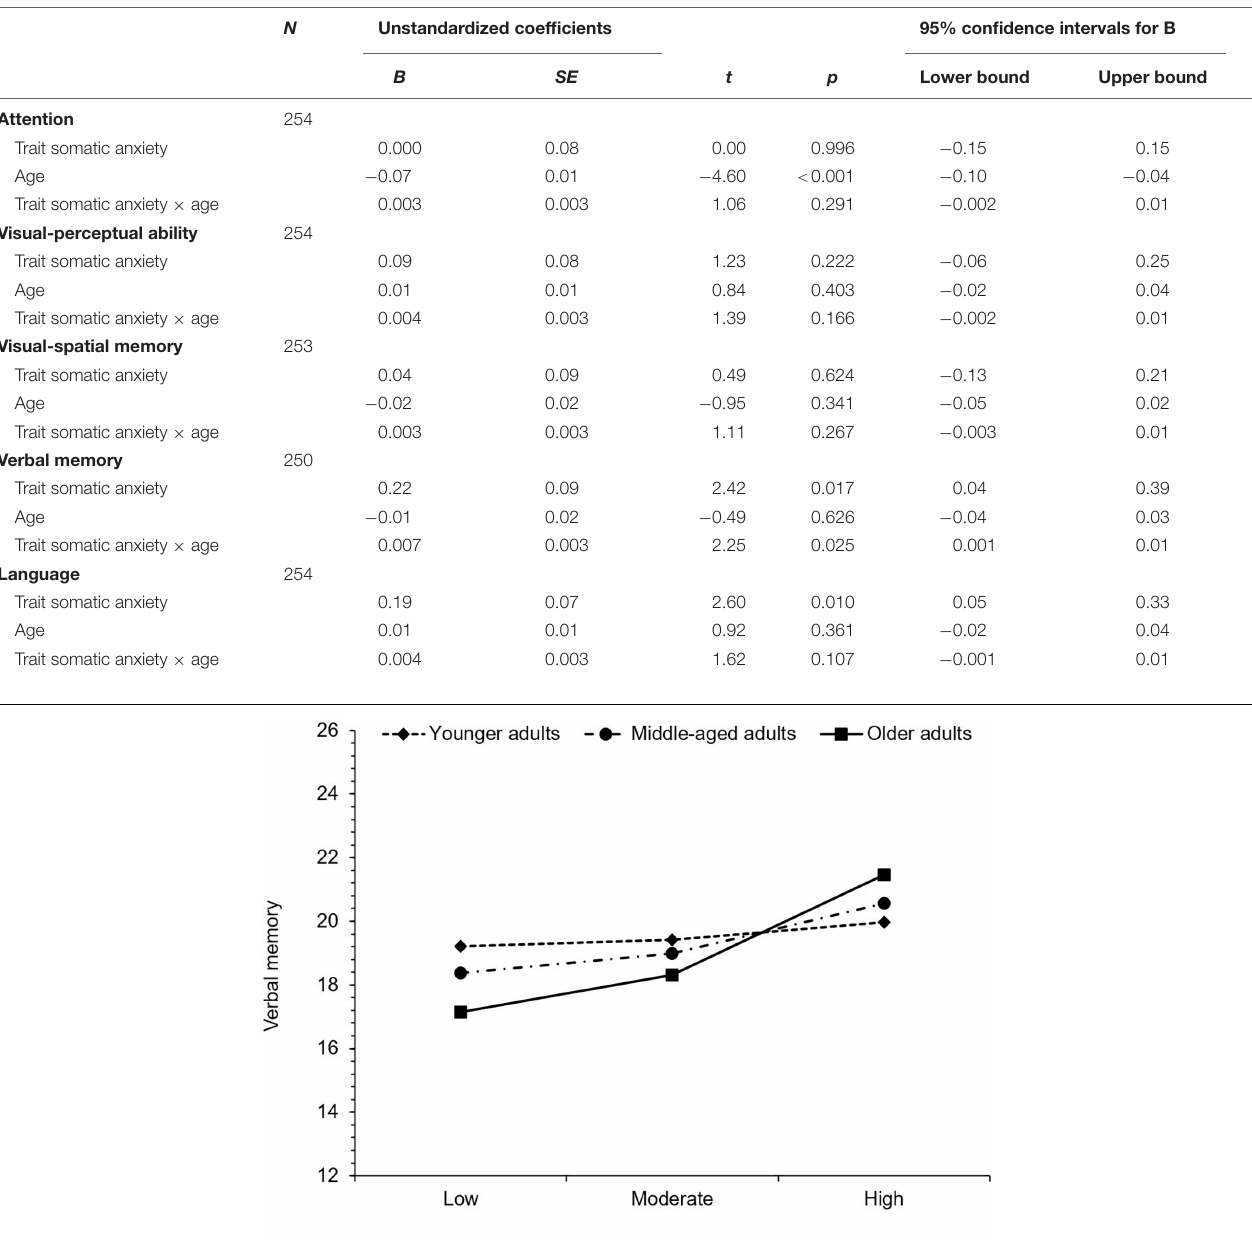
TABLE 4 | Unstandardized coefficients, significance tests, and 95% confidence intervals for predictors of subjective cognitive difficulties in each moderated regression analysis including trait somatic anxiety as a predictor. N Unstandardized coefficients 95% confidence intervals for B